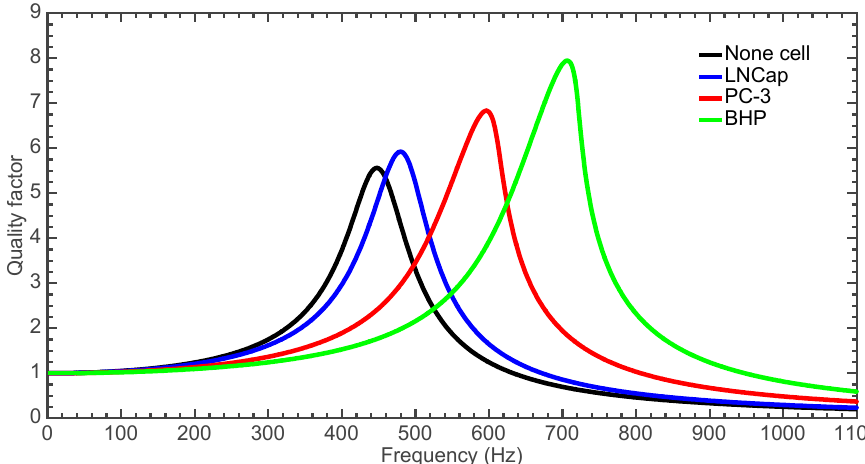
Figure 18. Frequency response of the microgripper when it squeezes three different cells types and without gripped cells.